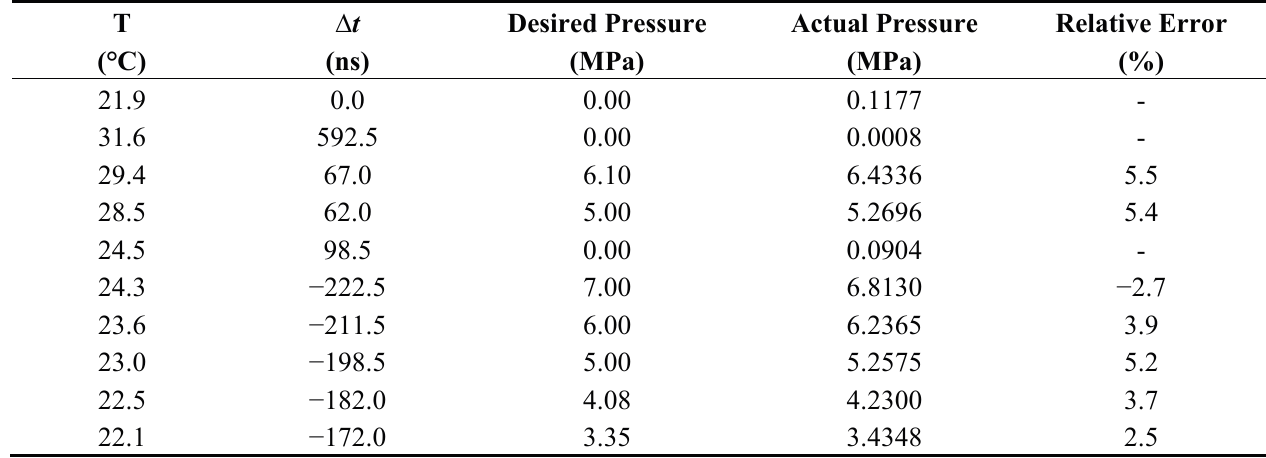
Table 3. Testing results with the neural